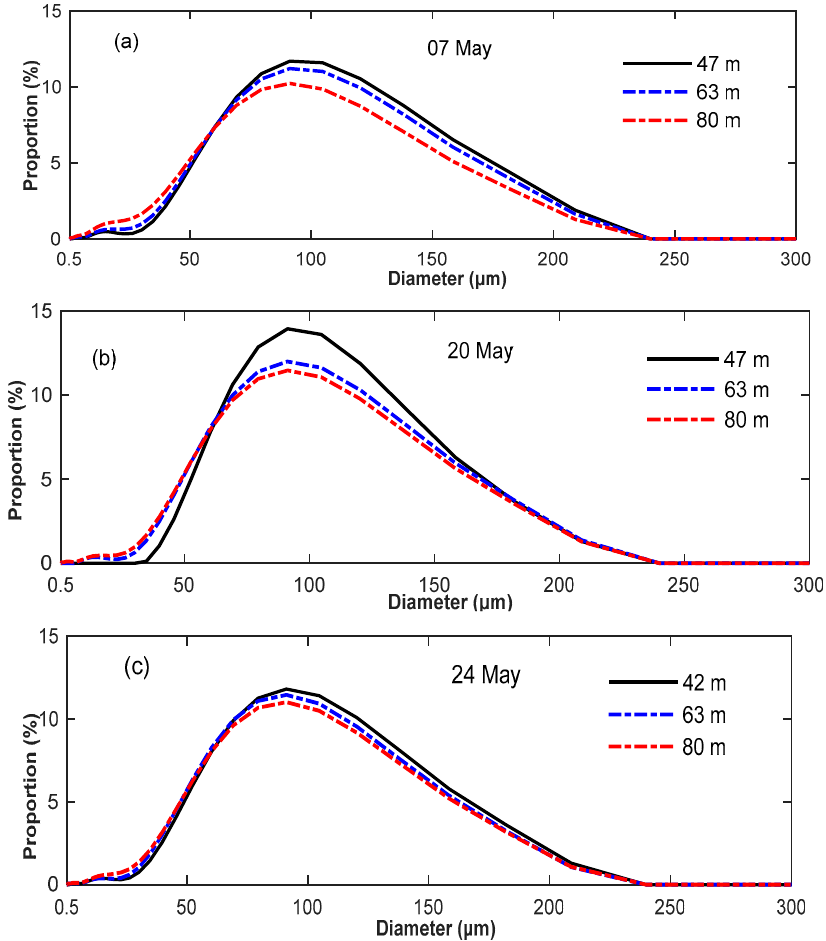
Figure 3. The particle proportion distributions obtained by the Laser Particle Size Analyzer (LPSA) ( a ) 7 May ( b ) 20 May ( c ) 24